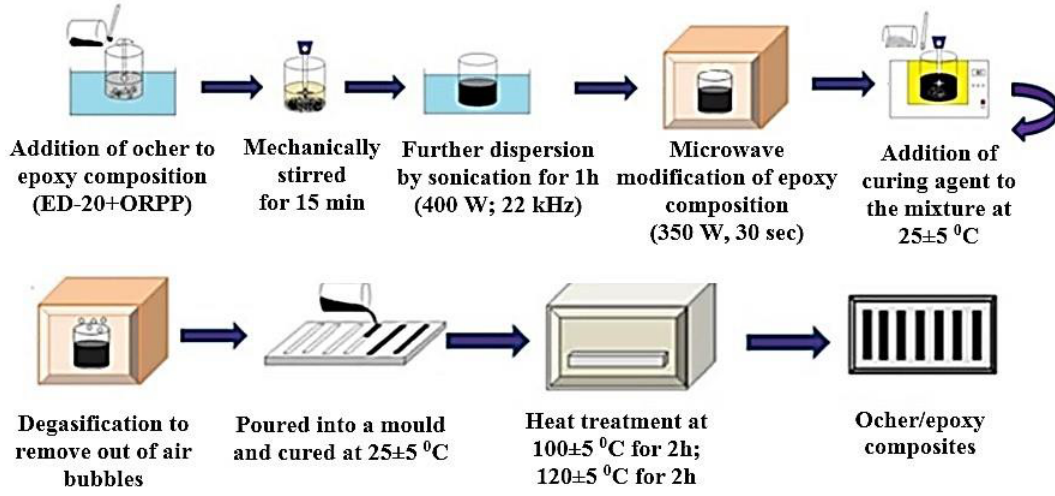
Figure 1. Schematic illustration for the preparation process of ocher/epoxy composites.